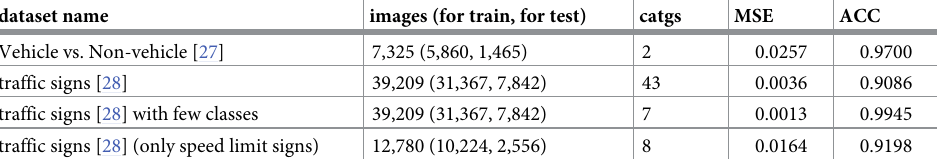
Table 2. Information of each dataset